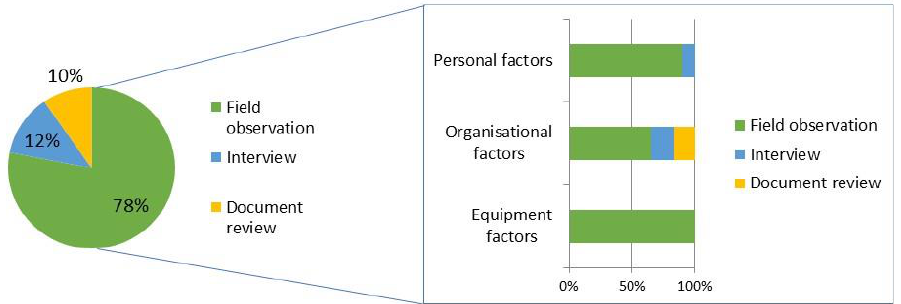
Figure 3. Sources for NCs identification.